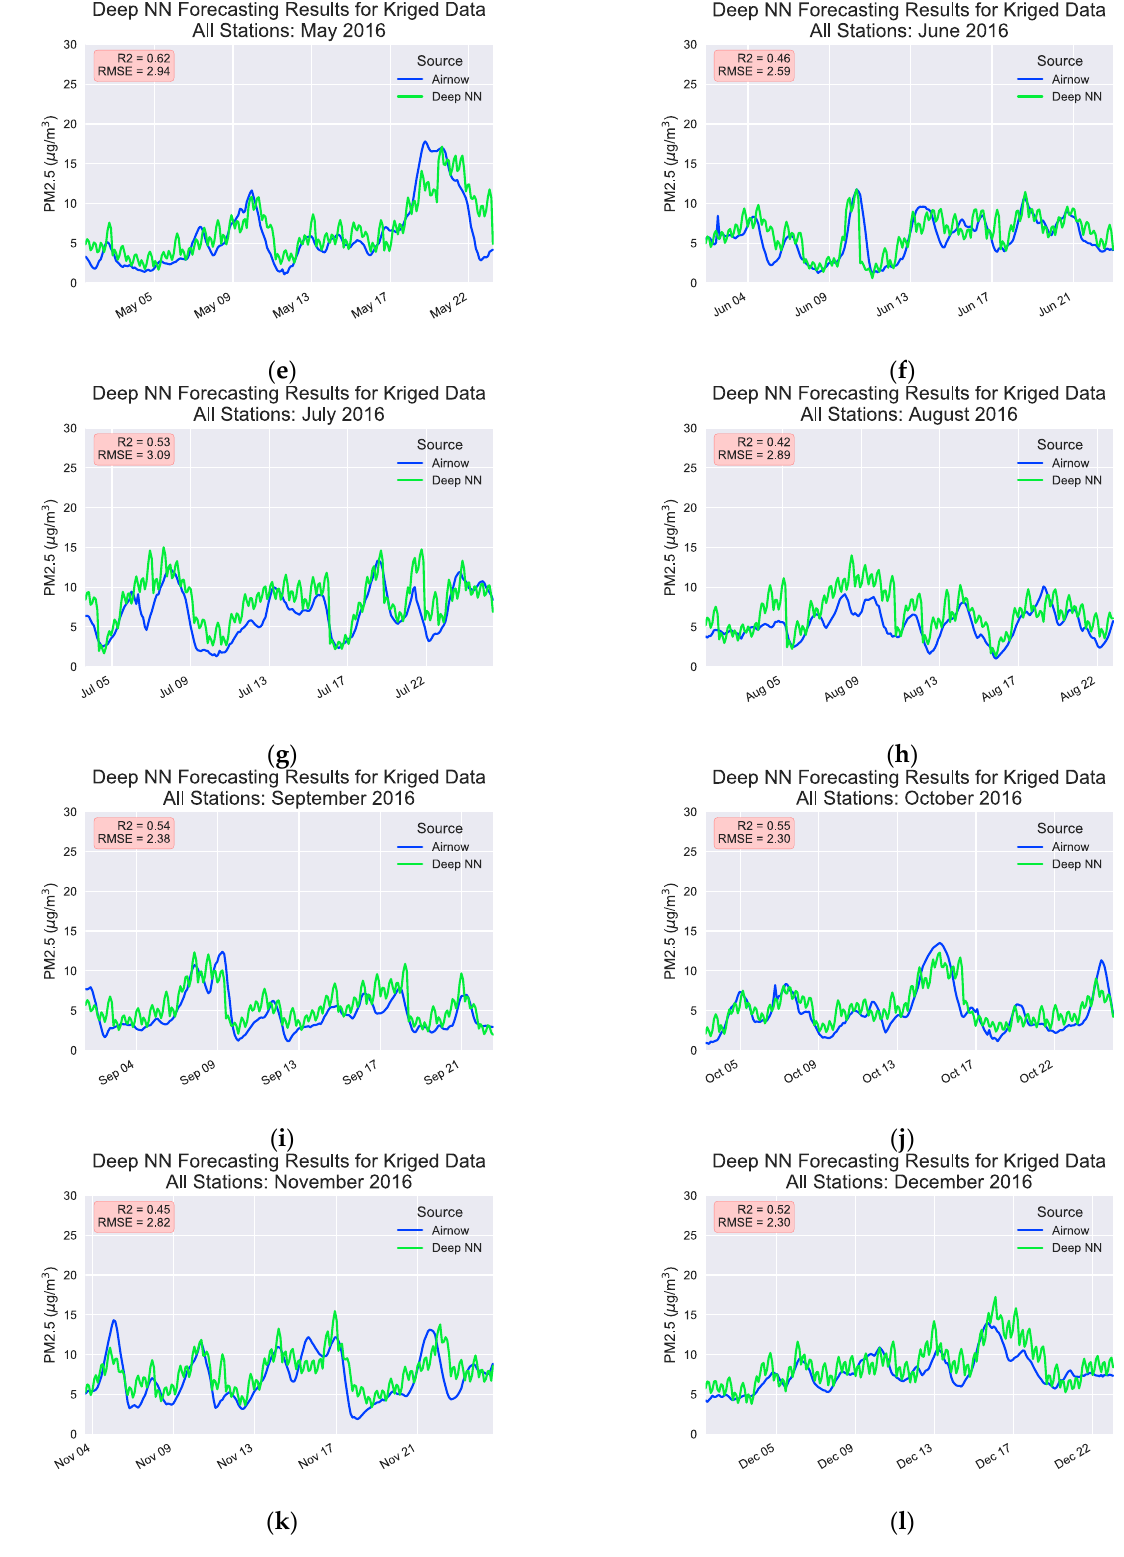
Figure A3. Time series plot, deep neural network ( a – l ). To highlight the effectiveness of the DNN as a forecaster, we show the time series plots of the forecasted Kriged values for all stations during year 2016. The dark lines represent average values for all stations, and the shaded lines that surround the dark ones represent the standard deviations between all stations.